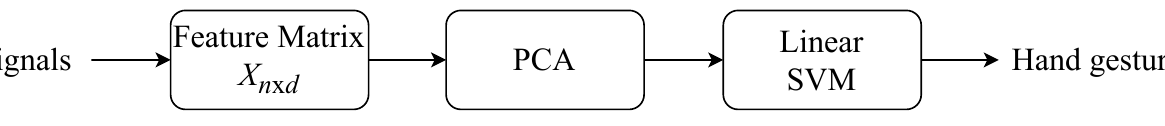
Figure 7. Final diagram of the classification process